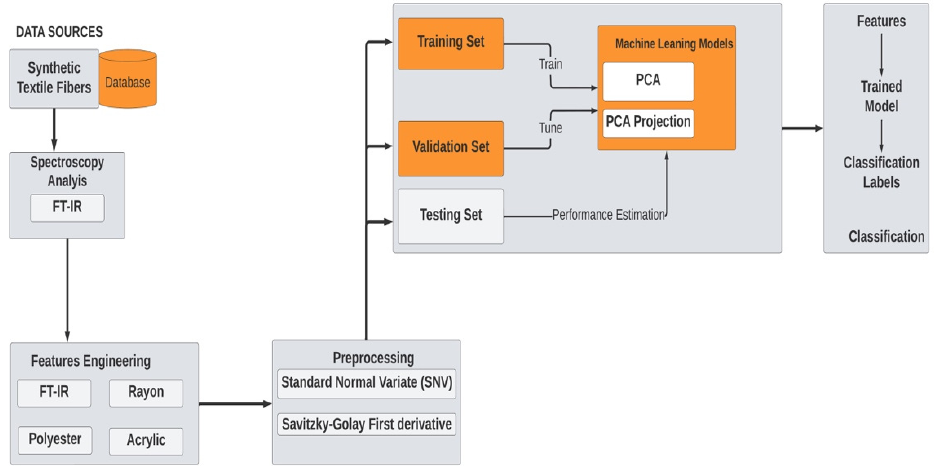
Figure 1. Data analysis